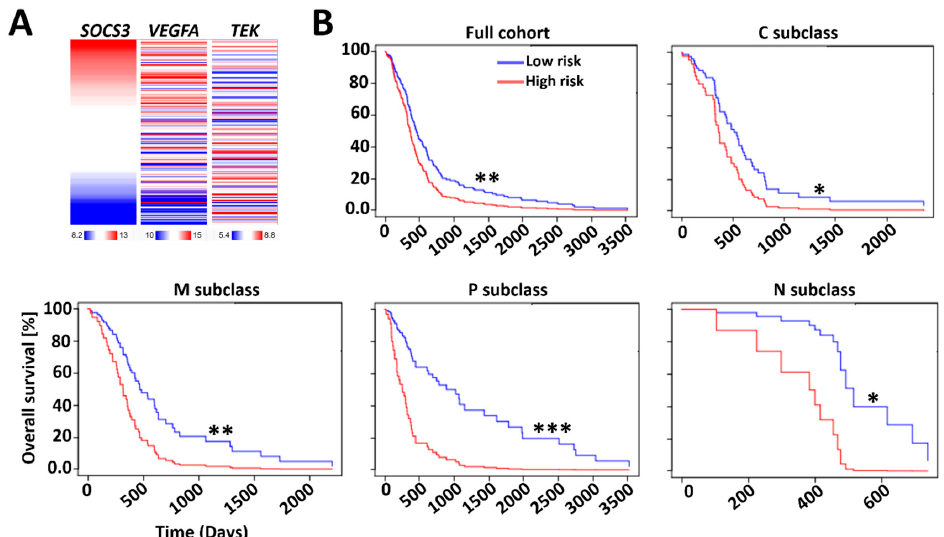
Figure 3. Survival analysis based on the impact of the multi-gene prognostic index (PI). ( A ) Heatmap analysis of expression levels of SOCS3 , VEGFA , and TEK was conducted on the UCSC Xena platform based on The Cancer Genome Atlas (TCGA)-GBM dataset ( n = 197). ( B ) Survival analysis based on